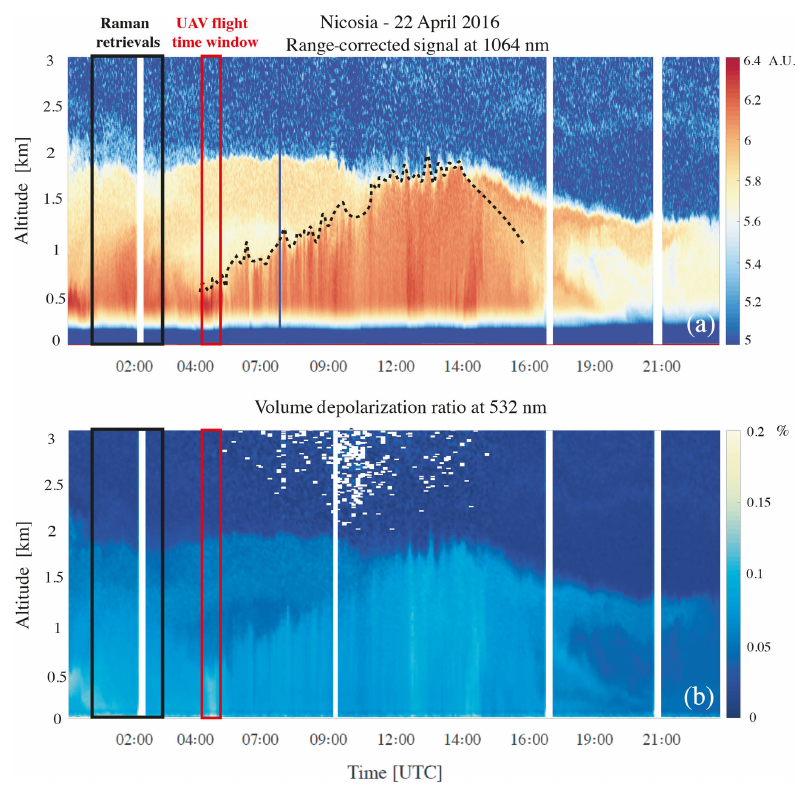
Figure 8. Range-corrected lidar signal at 1064nm (a) and volume linear depolarization ratio (b) reflecting the atmospheric conditions over Nicosia on 22 April 2016. Blue colour indicates weak backscattering, yellow–red colours in the range-corrected lidar signal indicate backscattering mainly from fine aerosols and dust, whereas the dotted line shows the PBL top. The lidar observations used for the comparison with the UAV measurements were those recorded between 04:22 and